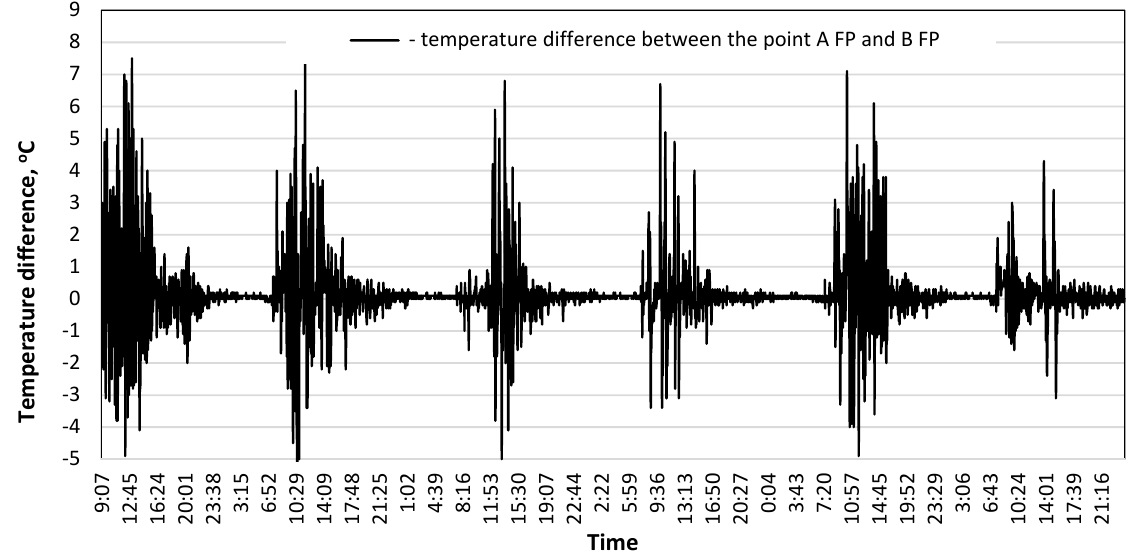
Figure 10. Temperature difference between at the beginning of the supply pipe ( A FP —on the roof) and at the beginning of the return pipe ( C FP —in the basement)—circulation loop for flat collectors which was registered at the same time.